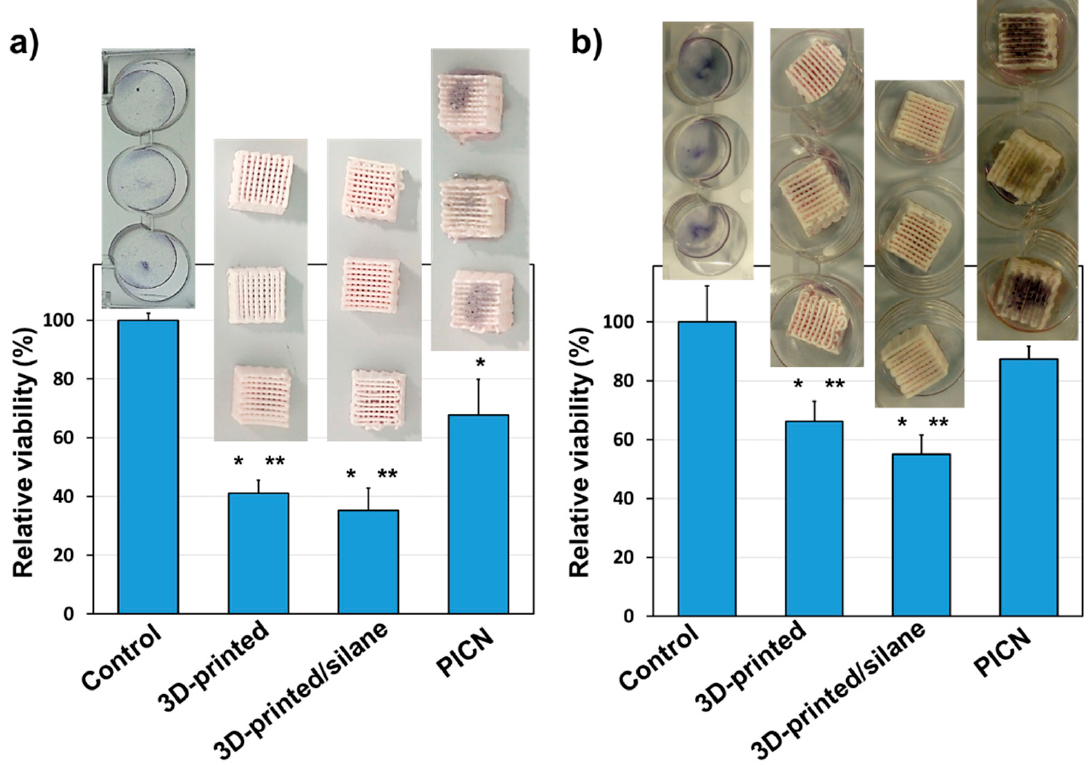
Figure 6. Viability of osteogenic MG-63 cells in the 3D scaffolds. Quantification of cellular adhesion ( a ) and proliferation ( b ). Above each bar, images of the MTT reaction by viable cells, appearing as diffuse or dark spots, are shown. * p < 0.05 vs. control, ** p < 0.05 vs. copolymer (ANOVA–Tukey’s test).